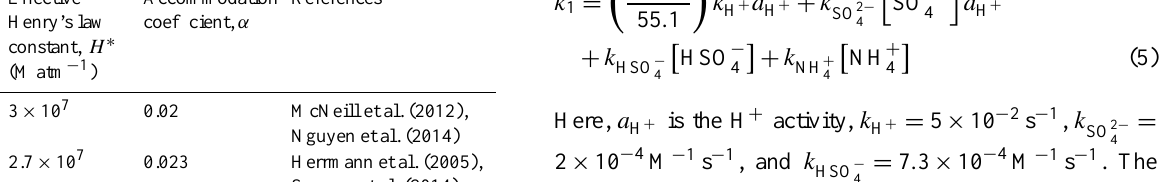
Table 1. Gas–aerosol mass transfer parameters in simpleGAMMA.